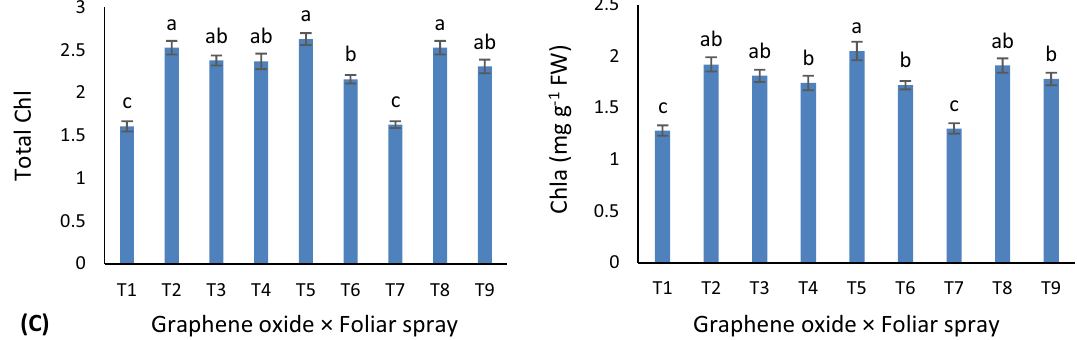
Figure 2. Mean comparisons for the interactions of salinity and soil-based application of graphene oxide ( A ), salinity and foliar spray ( B ), graphene oxide, and foliar spray ( C ) on total chlorophyll and chlorophyll a content in grapevine. Similar letters show no meaningful difference at 5% probability level by Duncan’s Multiple Range Test. Data are mean ± SD (n = 3